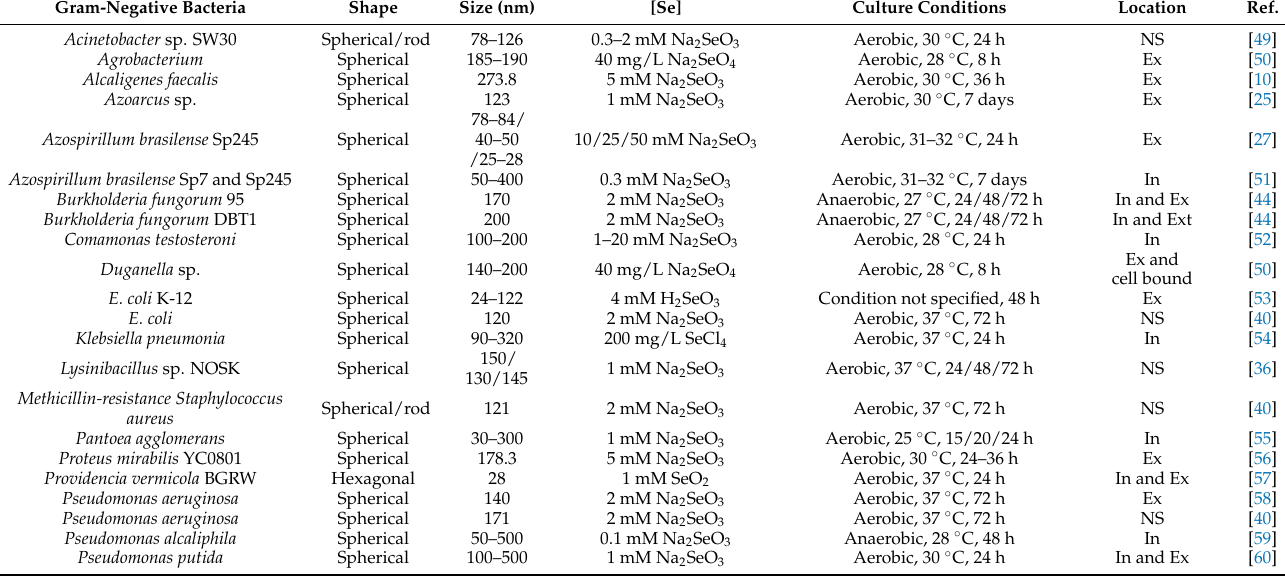
Table 1. Gram-negative and Gram-positive bacteria used for synthesis of